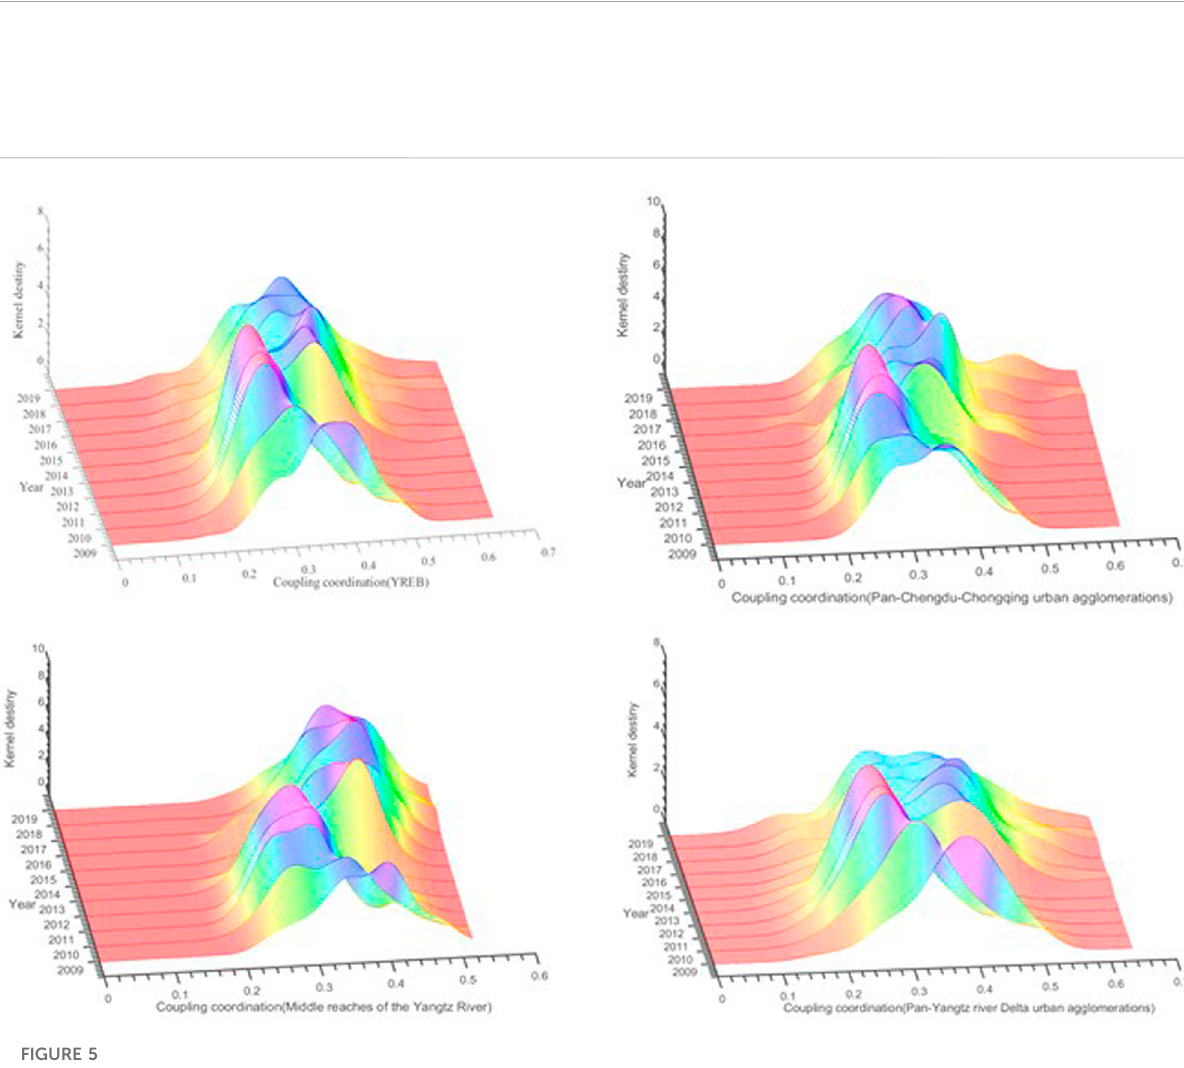
Frontiers in Environmental